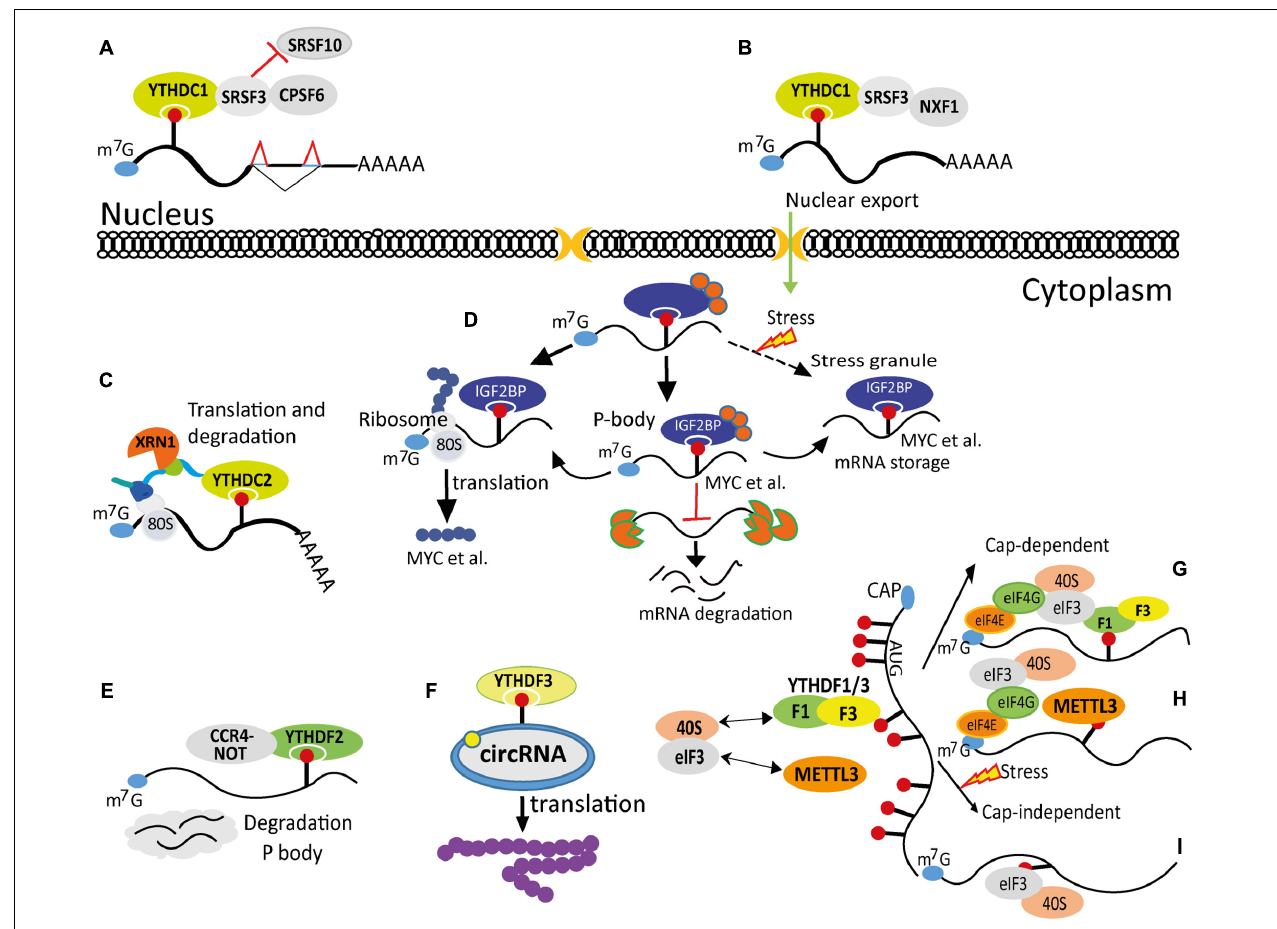
FIGURE 2 | Effects of N 6 -methyladenosine (m 6 A) methylation on messenger RNA (mRNA) fate. (A) m 6 A modification regulates mRNA splicing and polyadenylation via YTHDC1 and its associating factors SRSF3, SRSF10, and CPSF6. (B) m 6 A modulates mRNA nuclear export through YTHDC1, SRSF3, and NXF1. (C) m 6 A regulates mRNA translation and stability via YTHDC2-mediated recruitment of the ribosome and the XRN1 exoribonuclease. (D) m 6 A marks are bound by IGFBPs, which can regulate a subset of mRNA translation, decay in P-body, and storage in stress granules. (E) m 6 A modification regulates mRNA degradation in P-body through associating with the YTHDF2-CCR4-NOT complex. (F) m 6 A marks on circRNA modulate its translation via recruiting YTHDF3. (G) m 6 A marks recruit YTHDF1/YTHDF3 to enhance translation in a Cap-dependent manner. (H) METTL3 serves as an m 6 A reader and increases translation via recruiting